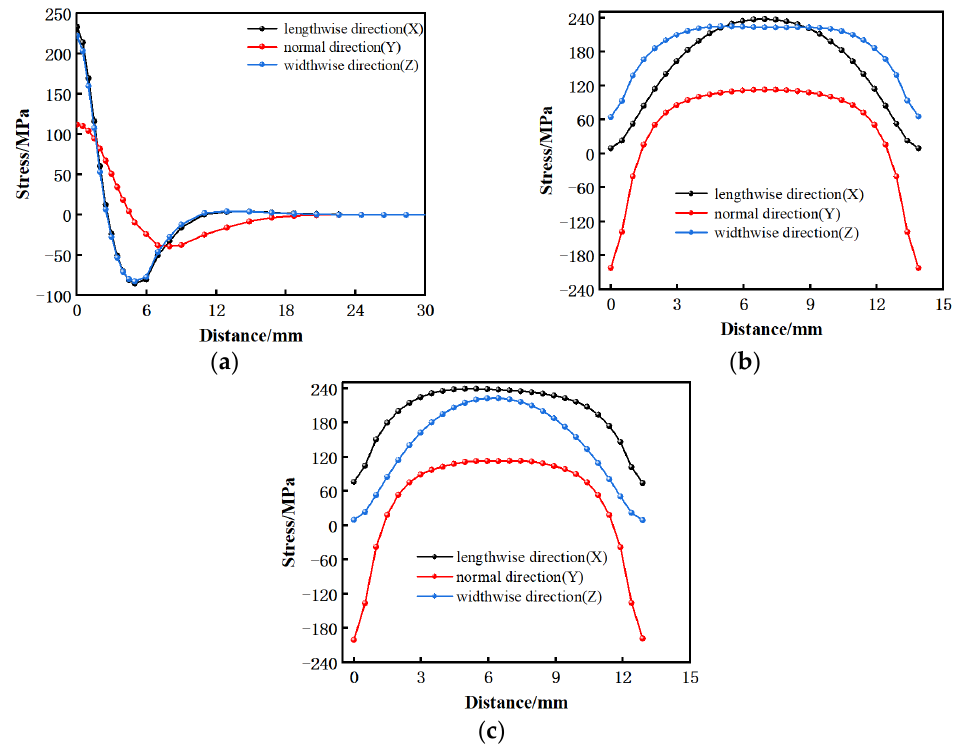
Figure 12. The residual stress distribution after cooling process; ( a ) path 1; ( b ) path 2; ( c ) path 3. Take four points at 0 mm, 1 mm, 3 mm, and 6 mm from the welding surface on path 1. Because the stress distribution on path 2 is similar to that on path 3, only three points at 2 mm, 4 mm, and 6 mm from the weld center on path 2 are taken. Extract the stress change curves of these points along the lengthwise of the welding surface, as shown in Figure 13. It can be seen from Figure 13b,c that the stress along the lengthwise direction, whether perpendicular to the welded surface or along the welded surface path, increases slowly from the 5th to the 20th second of cooling, and the residual stress is basically stable at the 20th second.